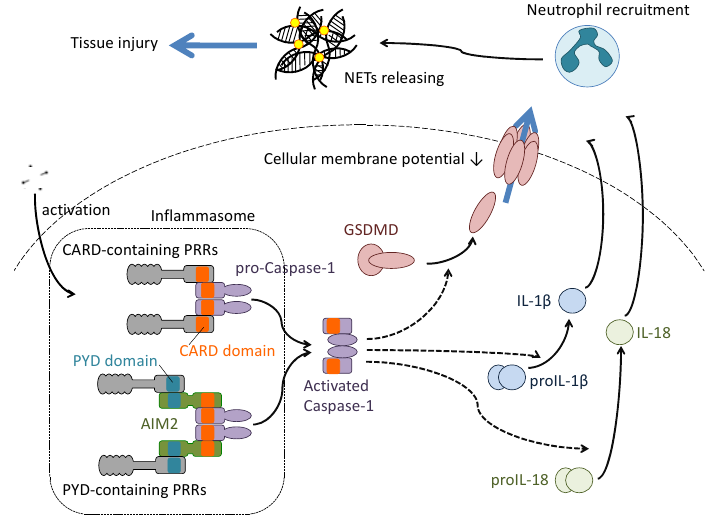
Figure 4. Molecularly ‐ defined pyroptosis induction in influenza virus infection. Several components of the influenza virus particle are recognized by both CARD ‐ containing and PYD ‐ containing PRRs. Recognition by the PRRs induces aggregation of caspase ‐ 1 to activate the cellular enzyme. The aggregation of caspase 1 by PYD ‐ containing PRRs needs the adaptor protein absent in melanoma 2 (AIM2), which contains the PYD and CARD domains on its amino acid structure. The activated caspase 1 cleaves gasdermin D (GADMD), proIL1 β or proIL18 to convert these substrates to the active form. The activated GSDMD translocates from the cytosol to the cellular membrane to form a channel. The formation of the channel induces permeabilization of the cellular membrane to release IL1 β and IL18. These cytokines, once released, stimulate and recruit neutrophils to the infected local area. The recruited neutrophils endocytose the virus particles and release neutrophil extracellular traps (NET) to capture the pathogens. However, the host tissue damage brought about by the abundant production of NETs should be considered.